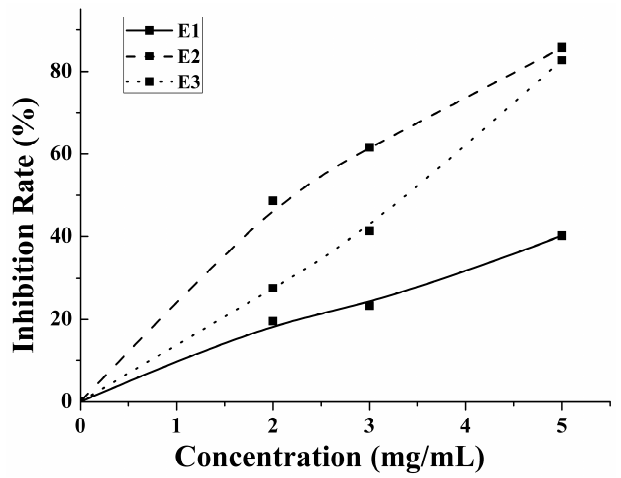
Figure 5. The anticoagulant activity of 2, 3 and 5 mg/mL E1–E3 were determined.